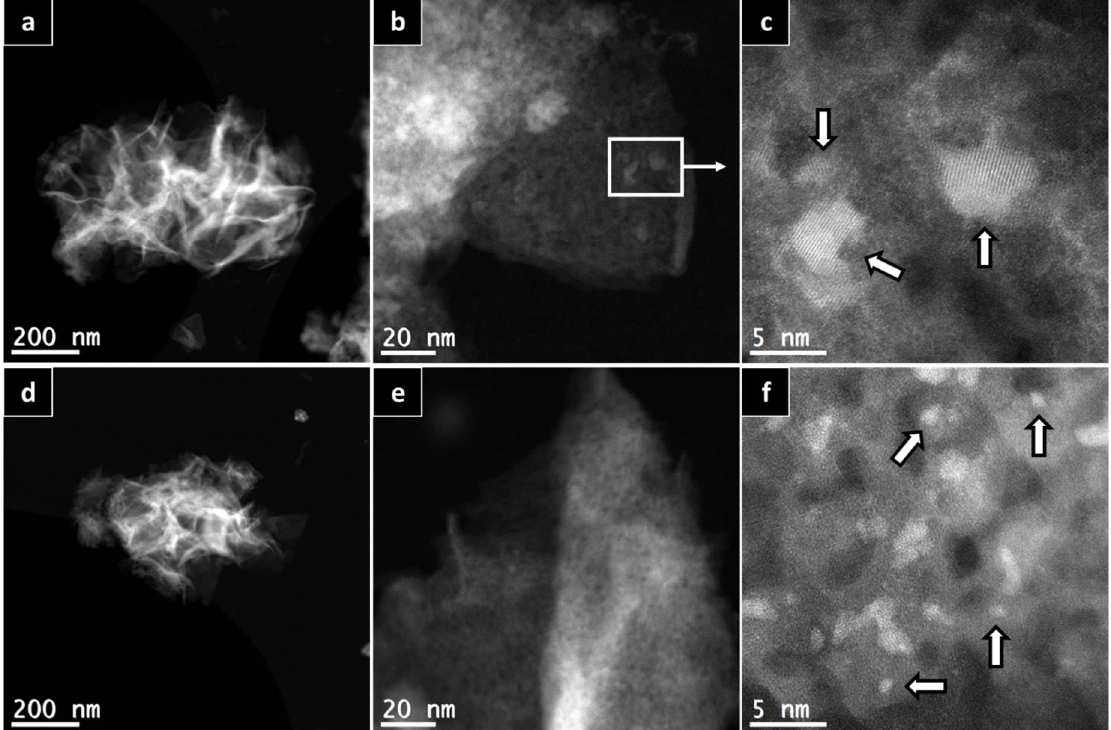
Figure 4. HAADF-HRSTEM patterns of AlNFs decorated with 10 wt% of Cu ( a – c ) and AlNFs decorated with 7 wt% of Cu ( d – f ). Catalysts were reduced prior to the analysis. White arrows point to few Cu nanoparticles in the sample.